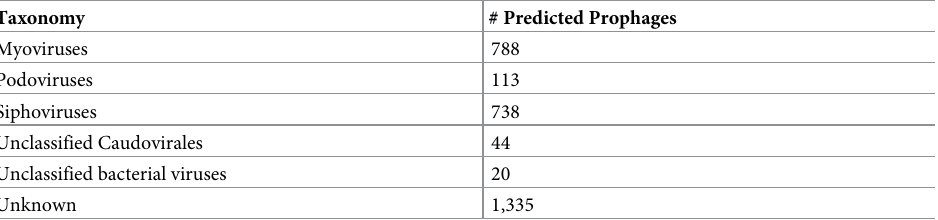
Table 1. Taxonomic classification of predicted prophages in urinary E . coli based on blastn sequence similarity to sequenced